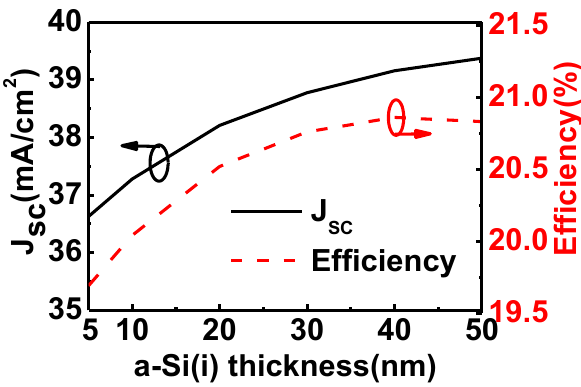
Figure 4. Short-circuit current density and efficiency of HIT solar cells as a function of the thickness of the top a-Si:H(i) layer when the bulk c-Si was 250 μm thick.